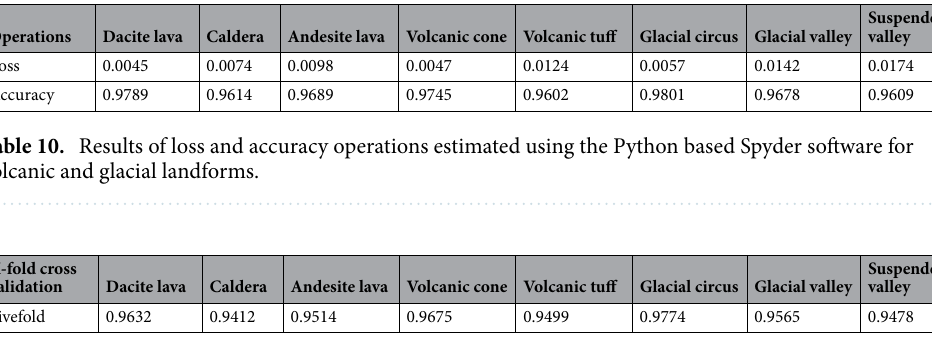
Table 11. Fivefold cross validation accuracy for volcanic and glacial landforms.